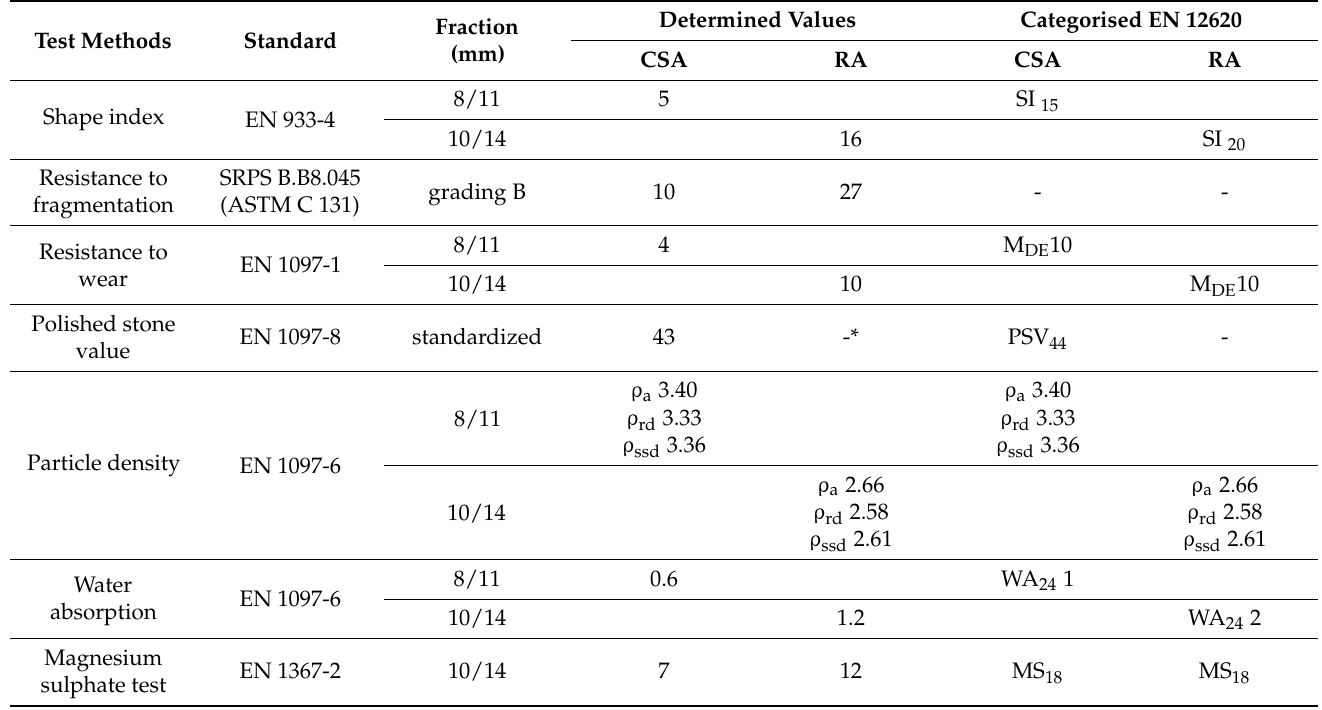
Table 3. Physical and mechanical characteristics of aggregates.